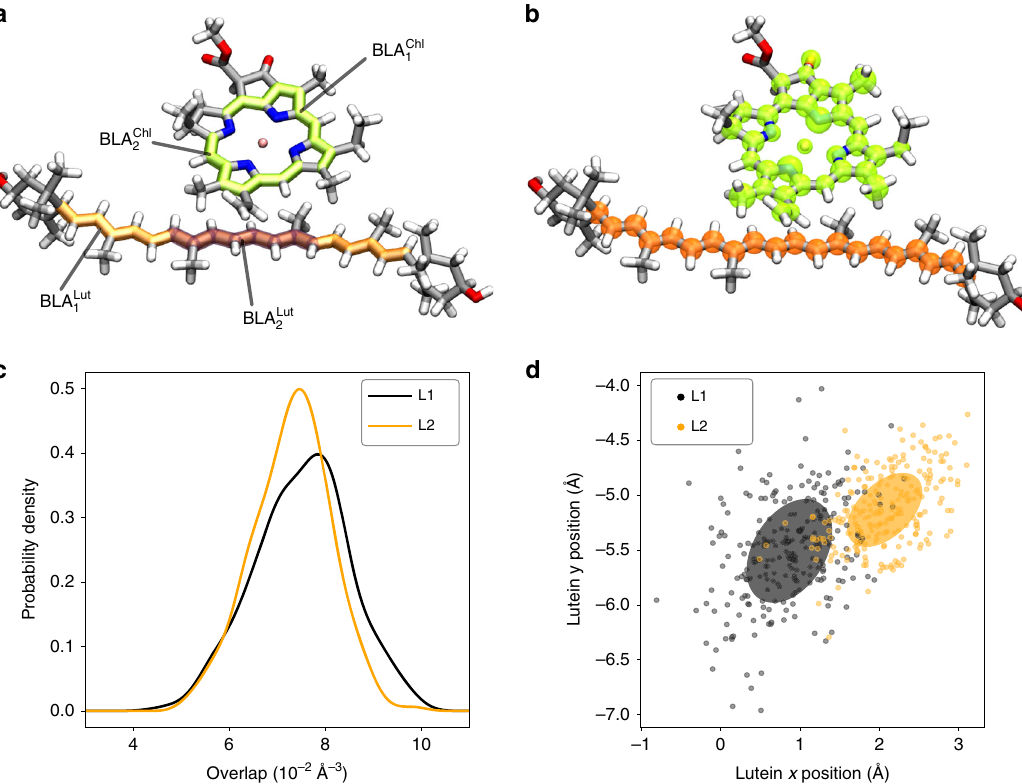
Fig. 3 Geometrical analysis of Lut – Chl pairs. De fi nitions of ( a ) BLAs and ( b ) atoms used for the density overlap. c Distribution of overlap values in sites L1 and L2. d Position of Lut1 (Lut2) in a xy reference frame de fi ned by the chlorine ring of Chl a 612( a 603).